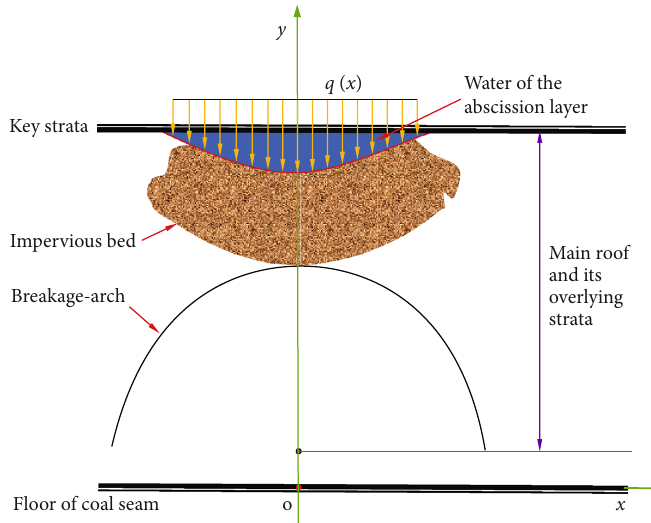
Figure 5: Mechanical model of roof structure when water inrush was about to occur.